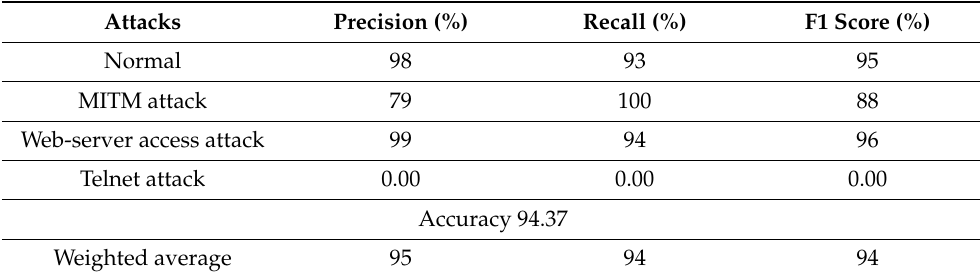
Table 10. Results of the LDA model using the multiclass classification dataset.